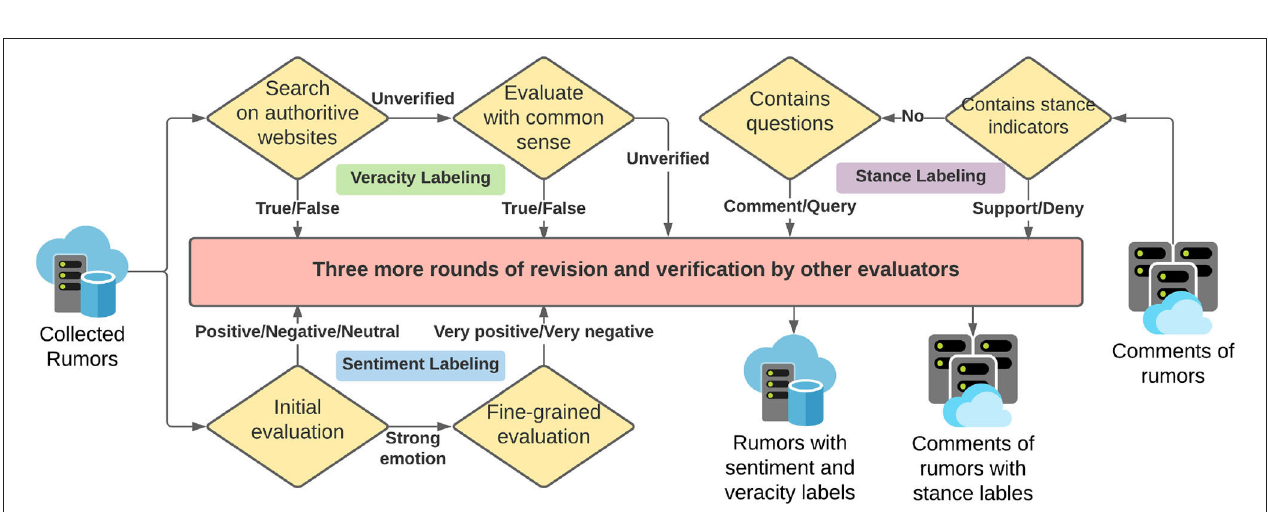
FIGURE 6 | Data labeling pipeline demonstration. We manually label the sentiment, veracity of rumor records, and the stance of comments.